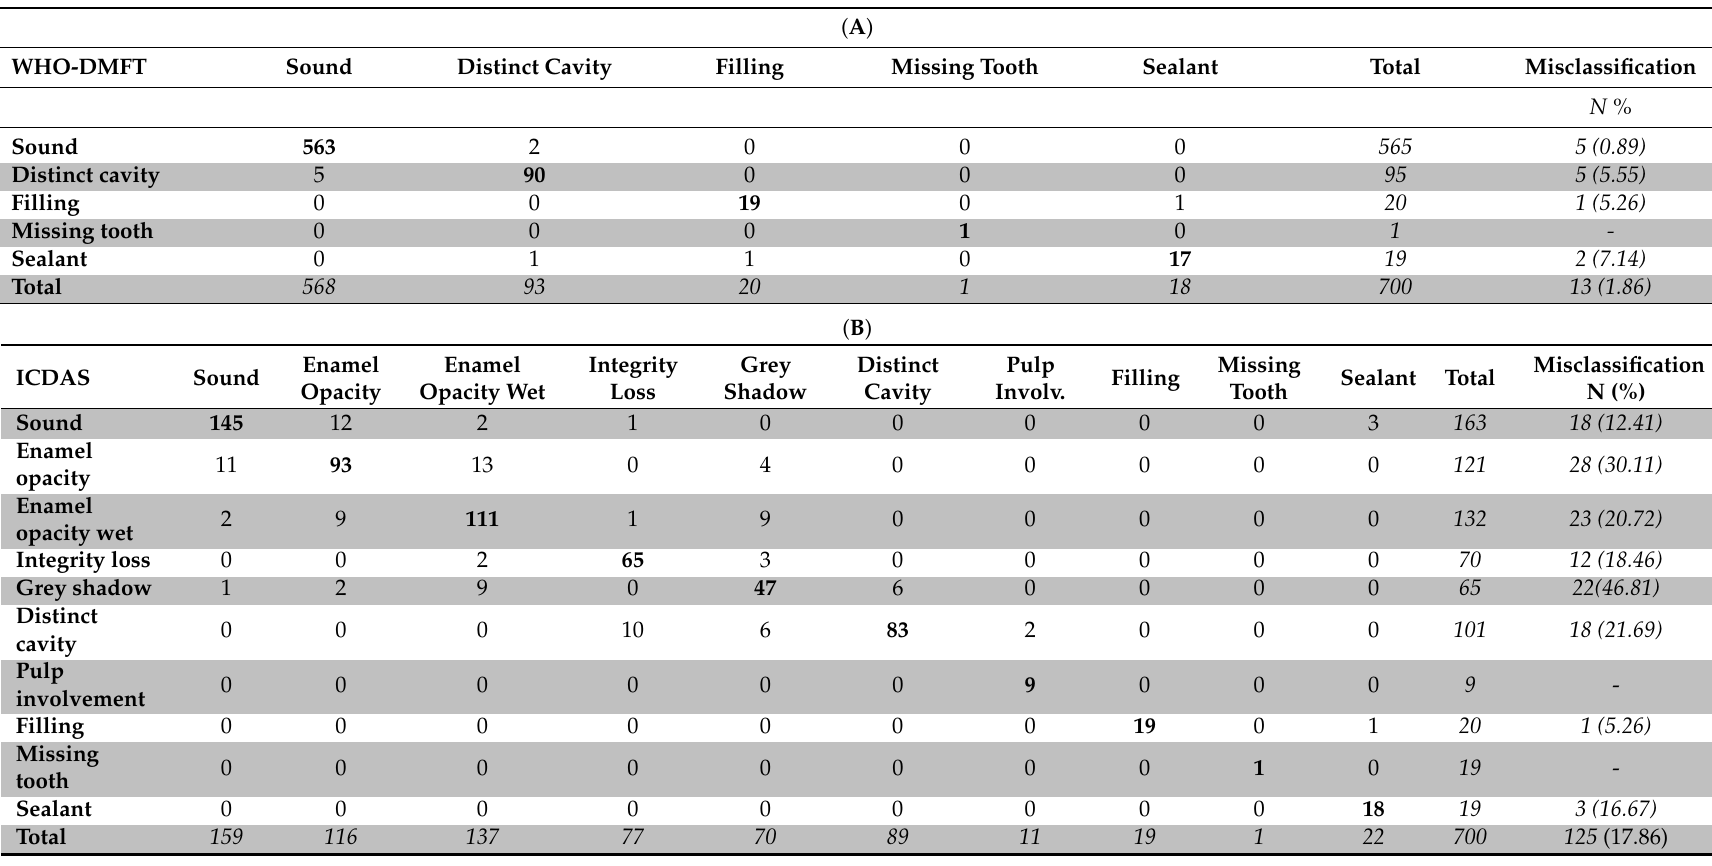
Table 5. Intra-examiner reliability: Classification according to the di ff erent methods: 5.a, WHO-DMFT; 5.b, ICDAS; 5.c, CAST; and 5.d, Nyvad Criteria. Percentage of misclassification error refers to the